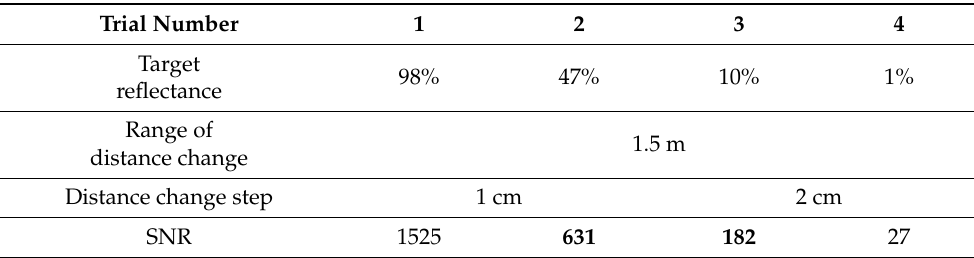
Table 4. Basic characteristics of carried experiments.